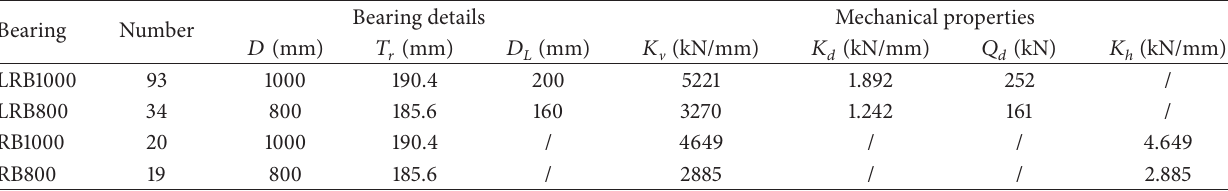
Figure 5: “Treasures fill the house” model (unit: mm): (a) elevation view; (b) 3D model. Table 3: Details and mechanical properties of bearings used in prototype